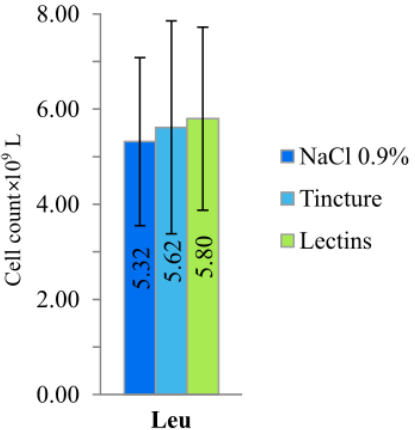
Figure 4. White blood cell count comparison after treatment of the mice for four times every seven days with NaCl 0.9%, EP roots’ tincture and hemagglutinin’s fraction.